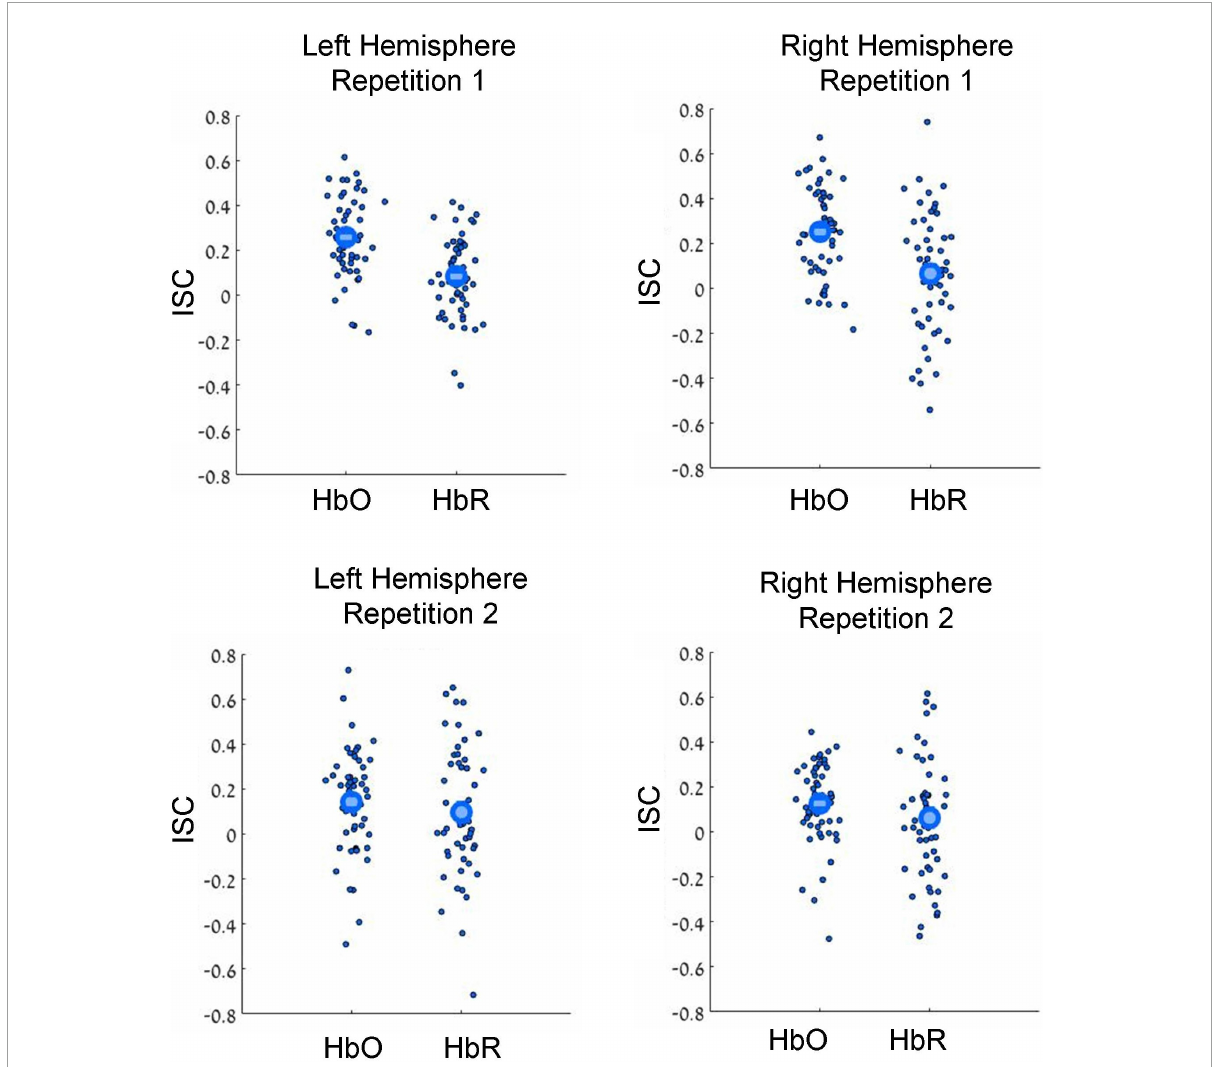
FIGURE2 Results of leave-one-subject-out ISC analysis. Results for the first and second movie repetitions are shown in the top and bottom rows, respectively, while results for the left and right hemispheres are shown in the top and bottom columns, respectively. Small dots reflect results for individual participants, while large circles reflect group averages. HbO and HbR stand for oxygenated and deoxygenated signals, respectively. Note beyond-zero correlations (ISC), which were particularly high in the HbO channels during the first movie repetition. Note the higher ISC in the HbO compared to HbR